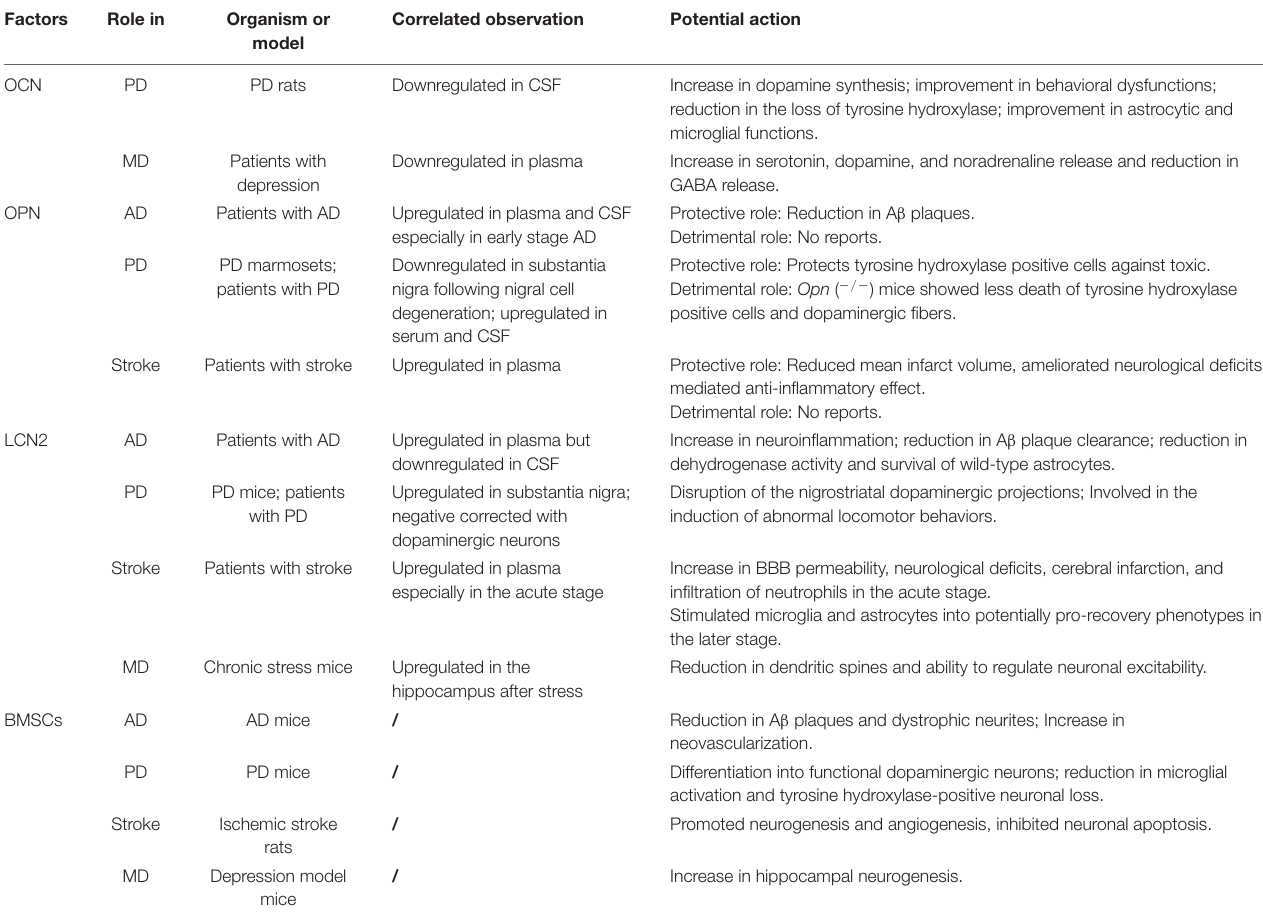
TABLE 1 | Bone-derived modulators involved in neurological disorders. Factors Role